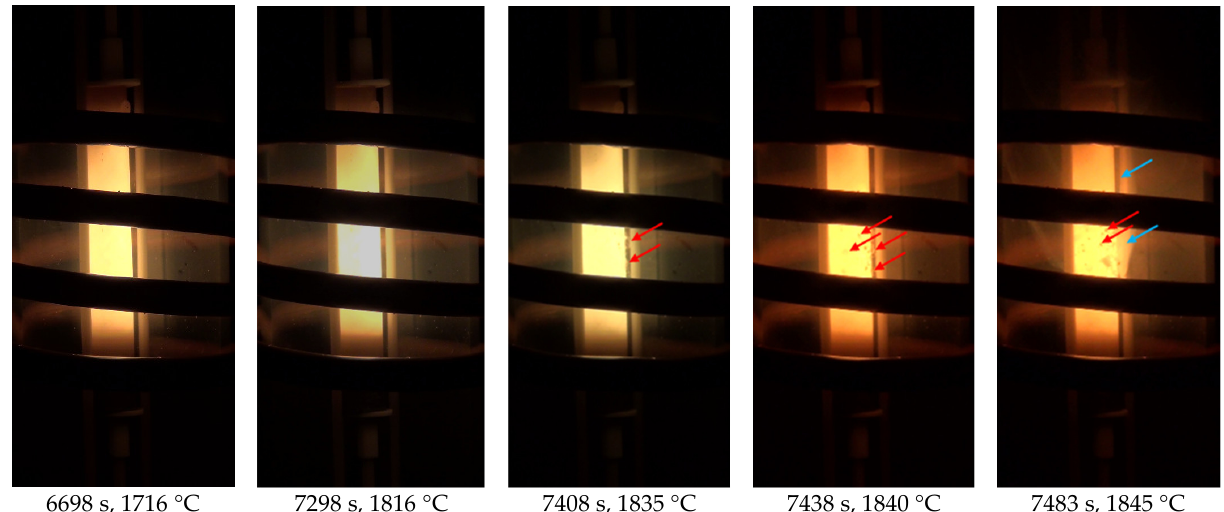
Figure 4. Video snapshots taken at the times and temperatures given during transient test SiC-01. Red arrows show positions of bubbles, blue ones the formation of smoke.